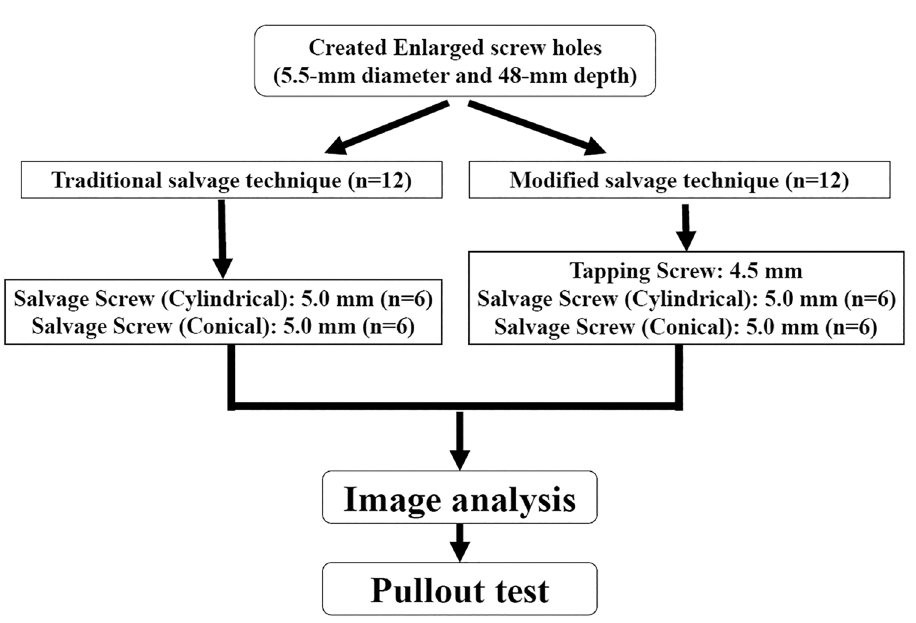
Figure 5. A flowchart of the study